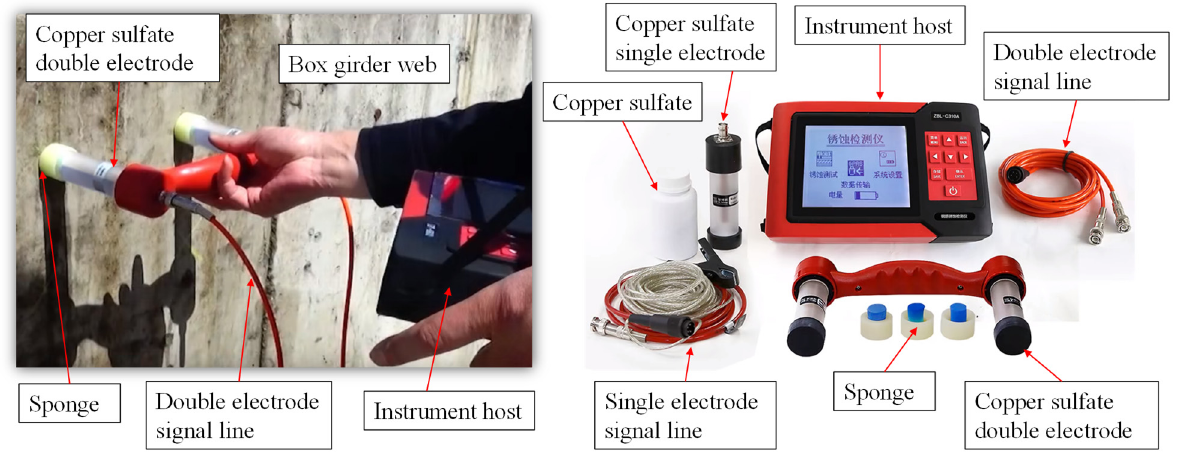
Figure 3. Corrosion potential testing of steel bars in concrete.